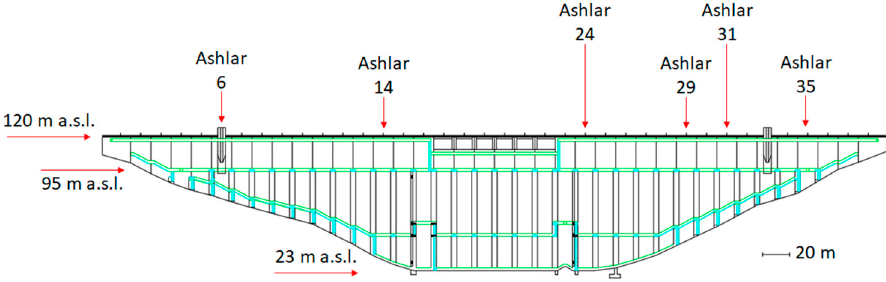
Figure 2. Front section of the Cantoniera dam and ashlar deployment.